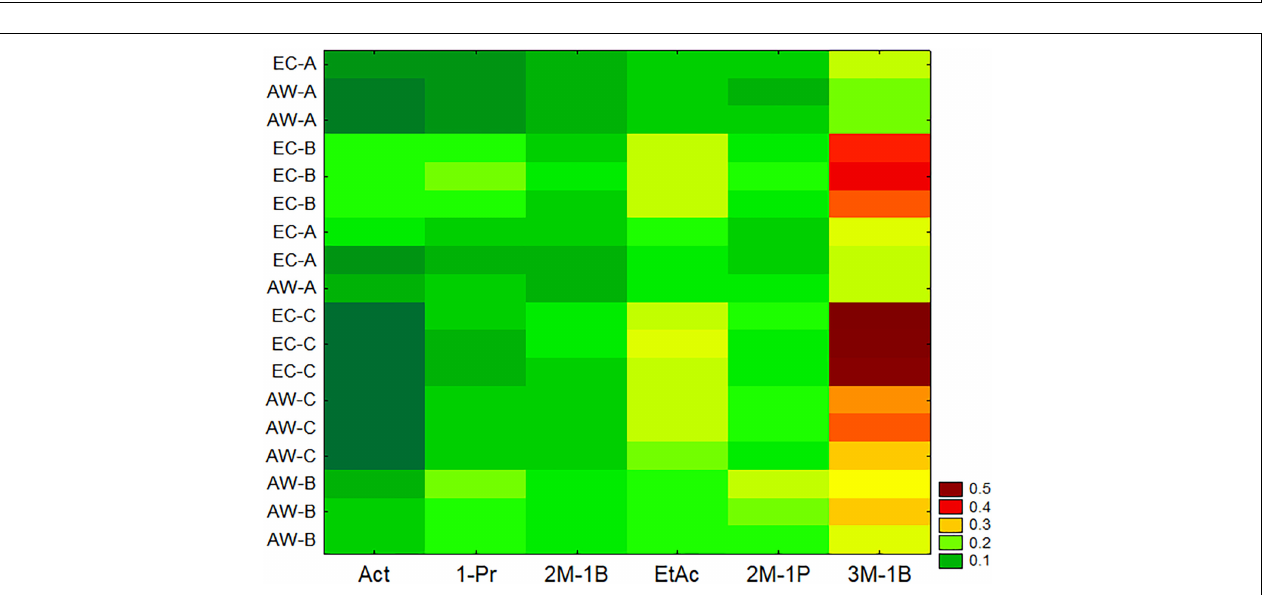
FIGURE 1 | Box plots of ethanol (% v/v per unit of consumed sugar) (A) and glycerol yields (g/L per unit of consumed sugar) (B) and volatile acidity (g/L per unit of consumed sugar) (C) produced by the two strains (EC, AW) in synthetic must trials carried out by three RUs (A, B, and C). Different letters on plots indicate significant differences ( p < 0.05).